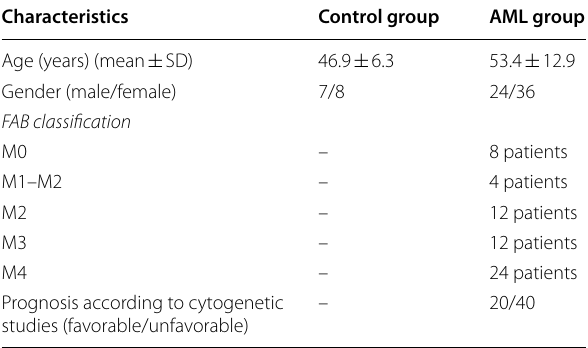
Table 1 Baseline characteristics of study participants Characteristics